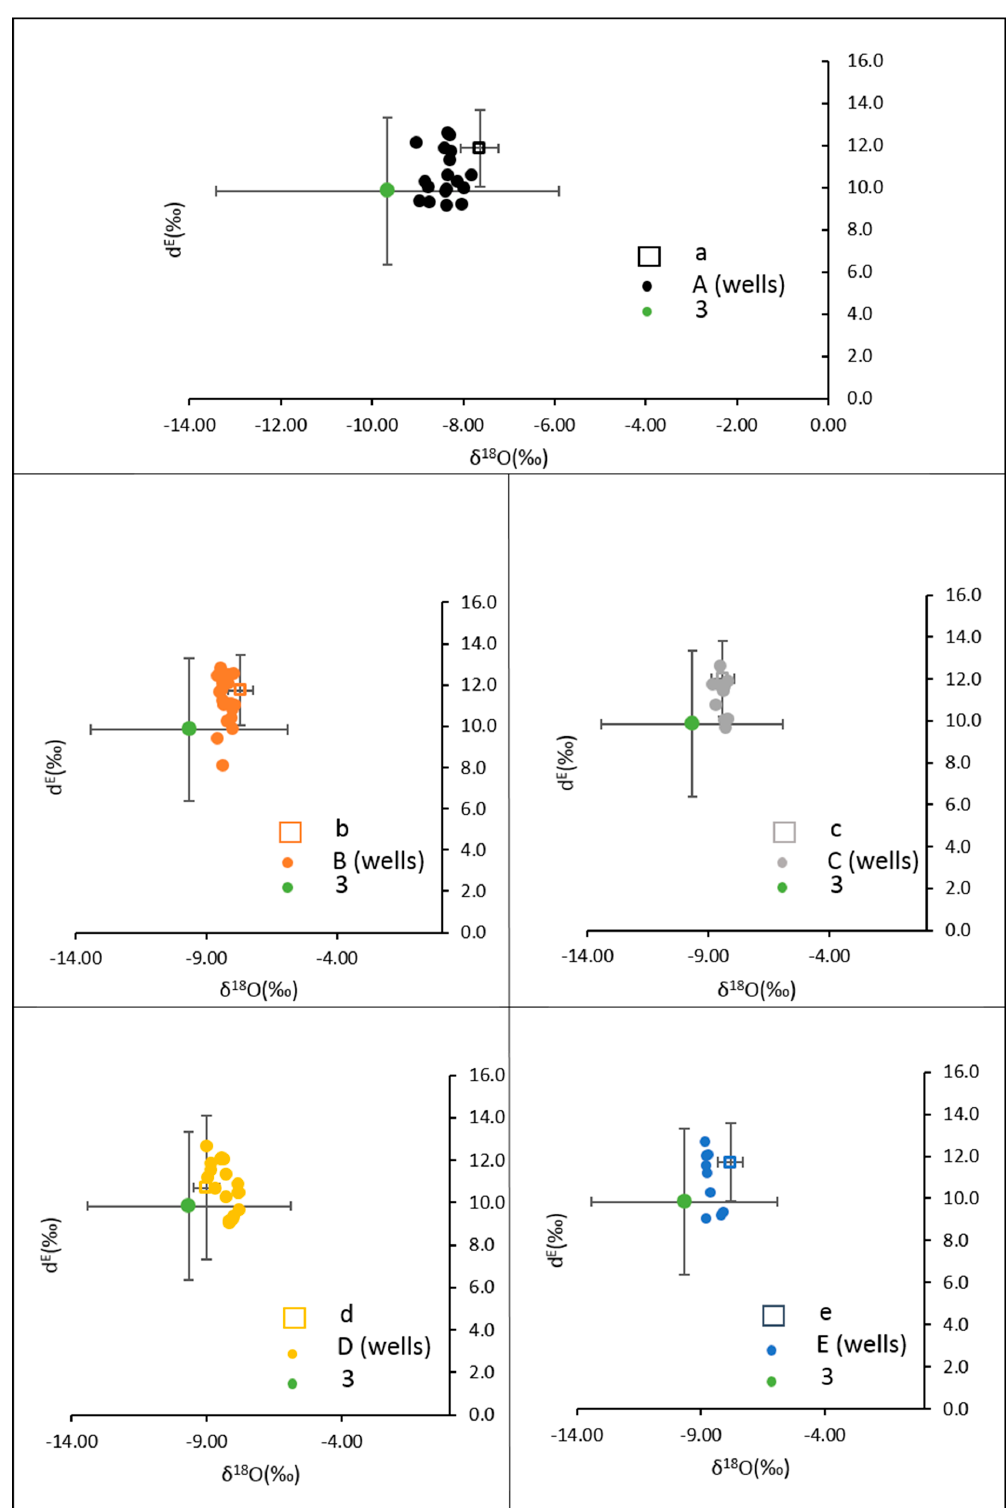
Figure 6. d E - δ 18 O plot in which groundwater (in form of aggregated data from each alluvial fan A, B, C, D, E) are reported together with the mean isotopic value of precipitation (from rain gauge (3)) and surface water (a, b, c, d, e). Error bars represent standard deviations (1 σ ).